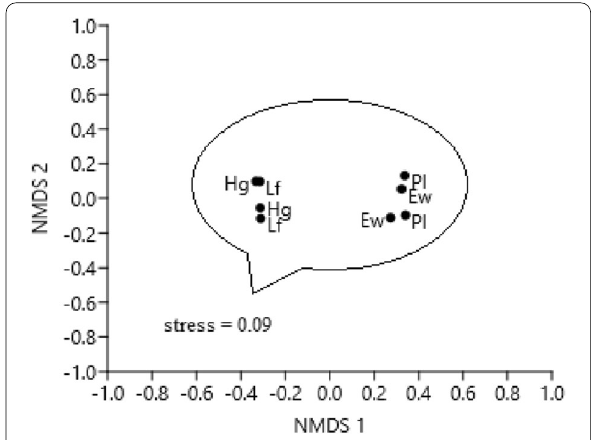
Fig. 4 Non-Metric Multidimensional Scaling (NMDS) representing clustering of habitat types (viz. Hg, Lf, Ew, Pl) based on species presence – absence among study sites (Bray-Curtis index, 95% ellipses) in study